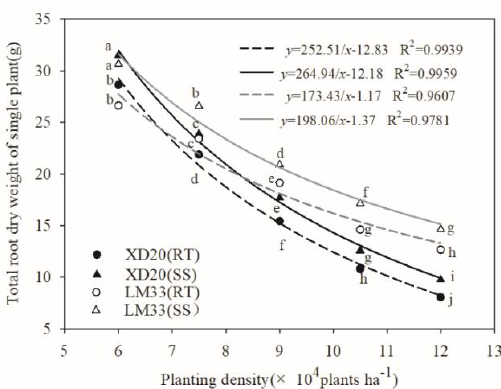
Figure 1. Root dry weight of high-yielding spring maize under different tillage methods and planting densities. Different letters on the graph indicate significant differences at p < 0.05.